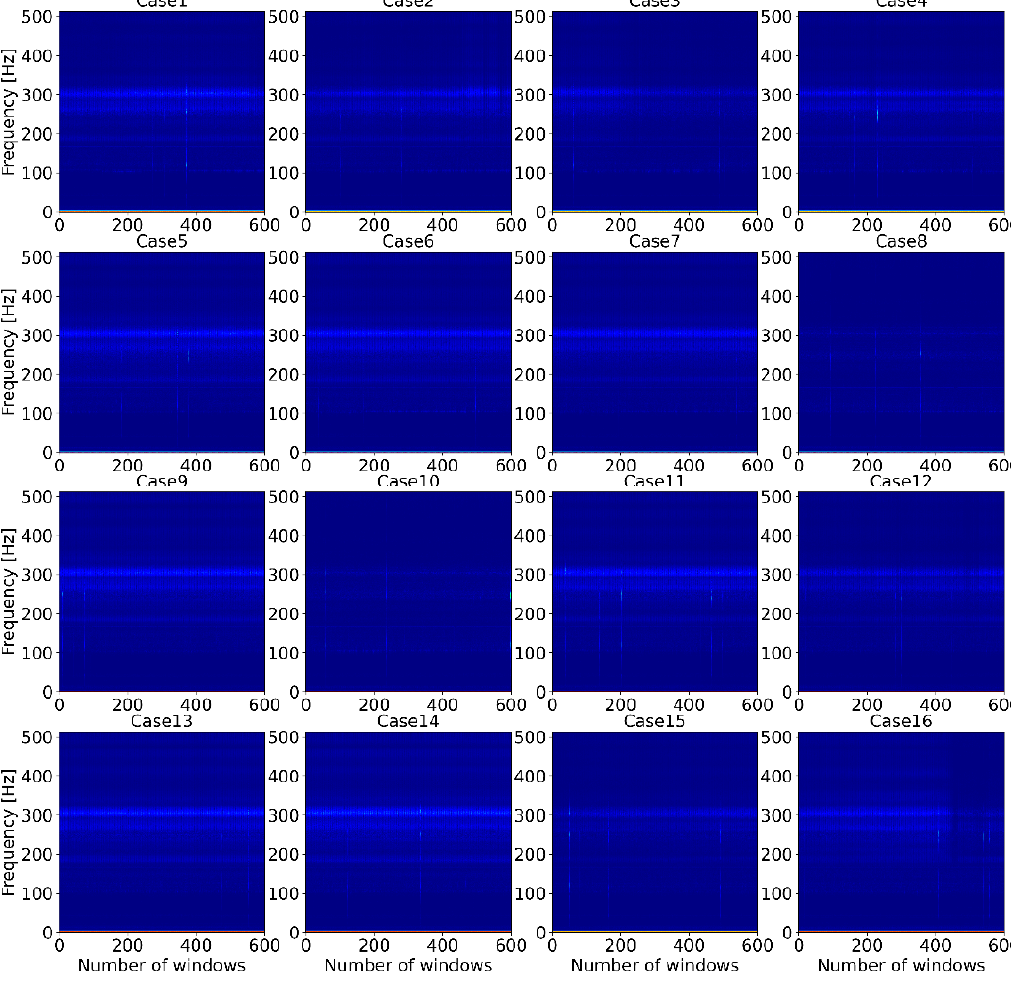
Figure 4. The spectrograms of short-time Fourier transform coefficients for all